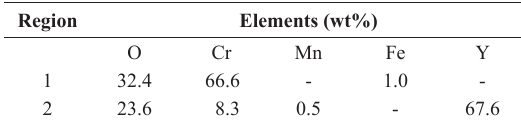
Table 2: EDS analysis results of regions 1 and 2 in